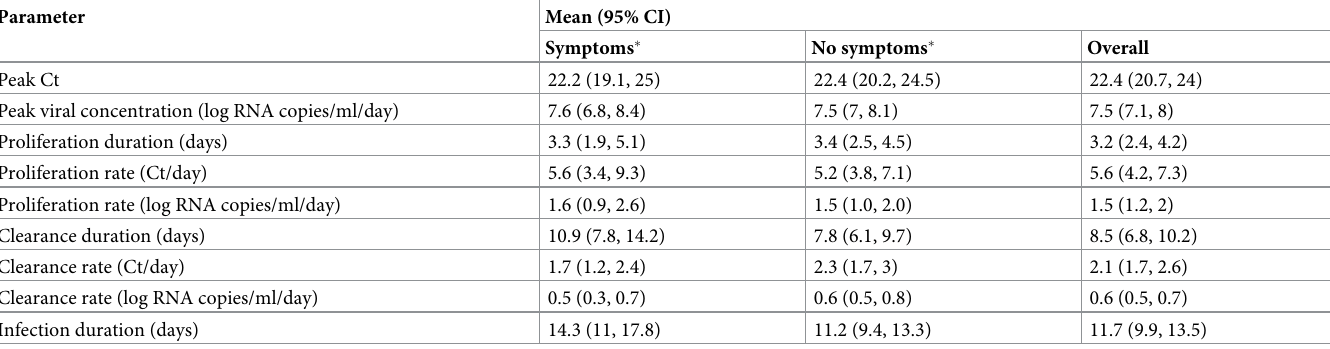
Table 1. Viral dynamic parameters, overall and separated by reported